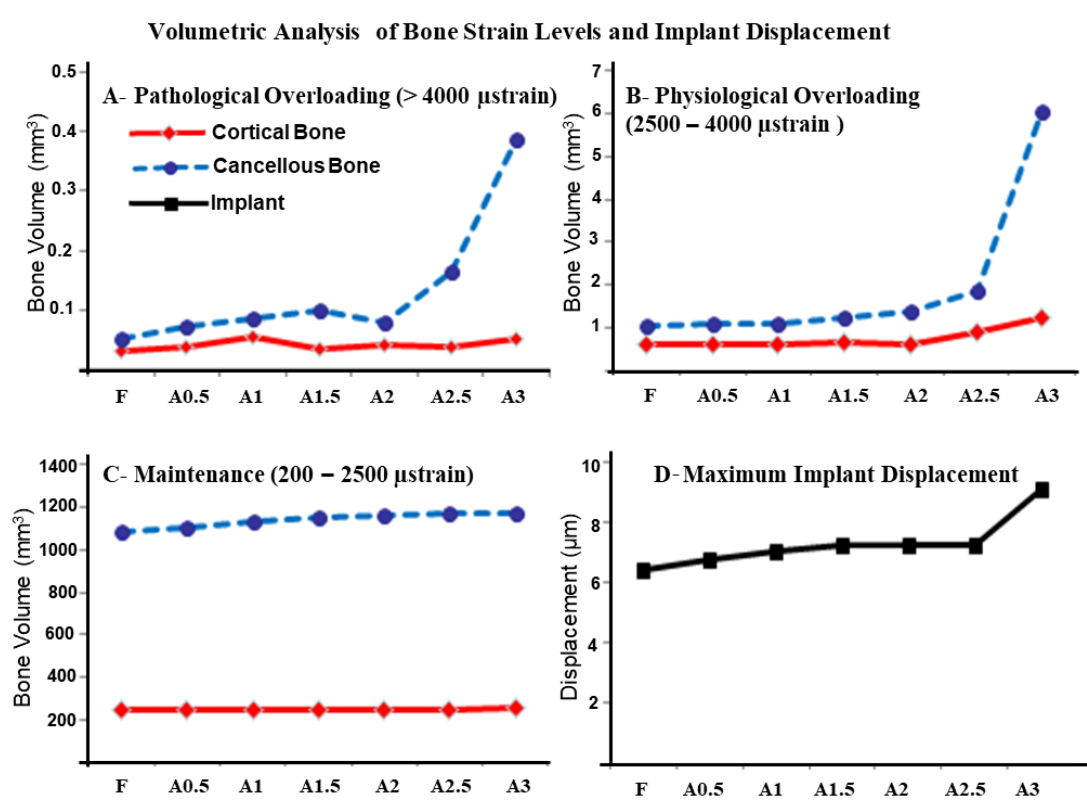
Figure 4. Volumetric analysis of bone strain levels and implant displacement: The volume of bone exhibited compressive strain values with ( A )—Pathological overloading (upper left), ( B )—Physiological overloading (upper right), and ( C )—Maintenance (lower left) windows in the cortical and cancellous bones in the fenestration F and augmented models (A0.5–A3). The maximum implant displacement ( µ m) upon occlusal force application is shown in panel ( D ) (lower right).